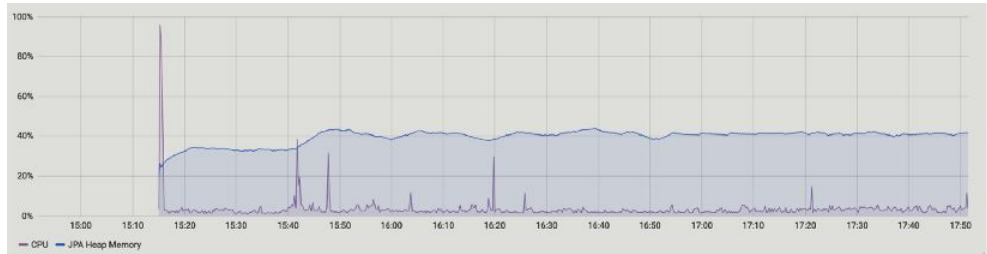
Figure 7. CPU and JVM heap memory usage at time t2 = 60 min.